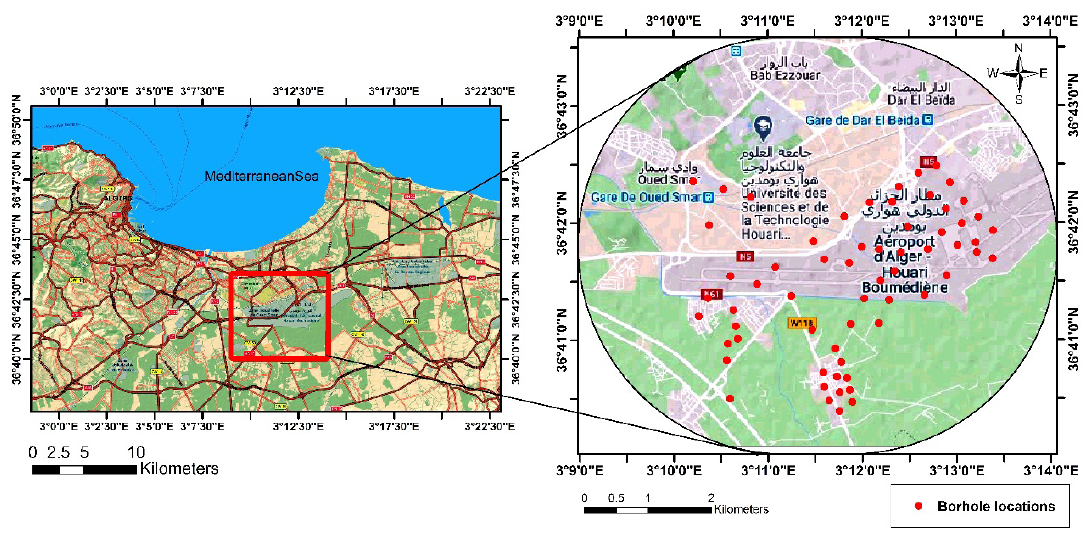
Figure 1: Geographical location of the study region and location of the CPT